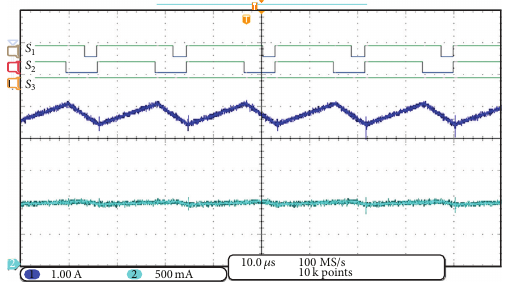
Figure 15: Operation when the energy is obtained from the battery set and the renewable source from top to bottom: 𝑆 1 , 𝑆 2 , 𝑆 3 , 𝐼 𝐿 𝐼 𝐿 2 . The current reference of both inductors is the